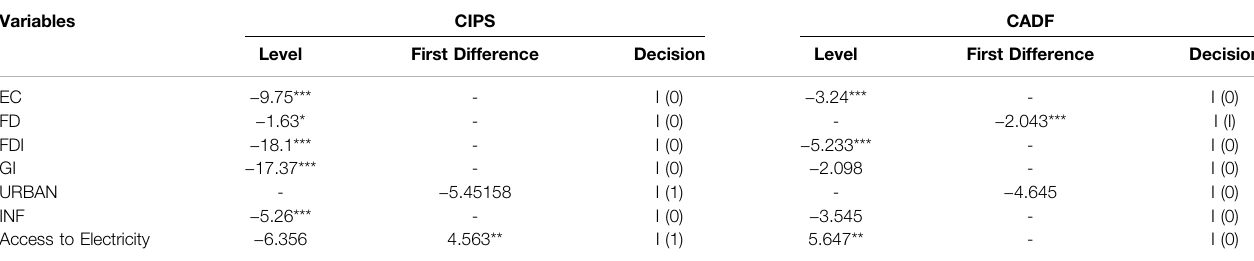
TABLE 6 | Unit root test